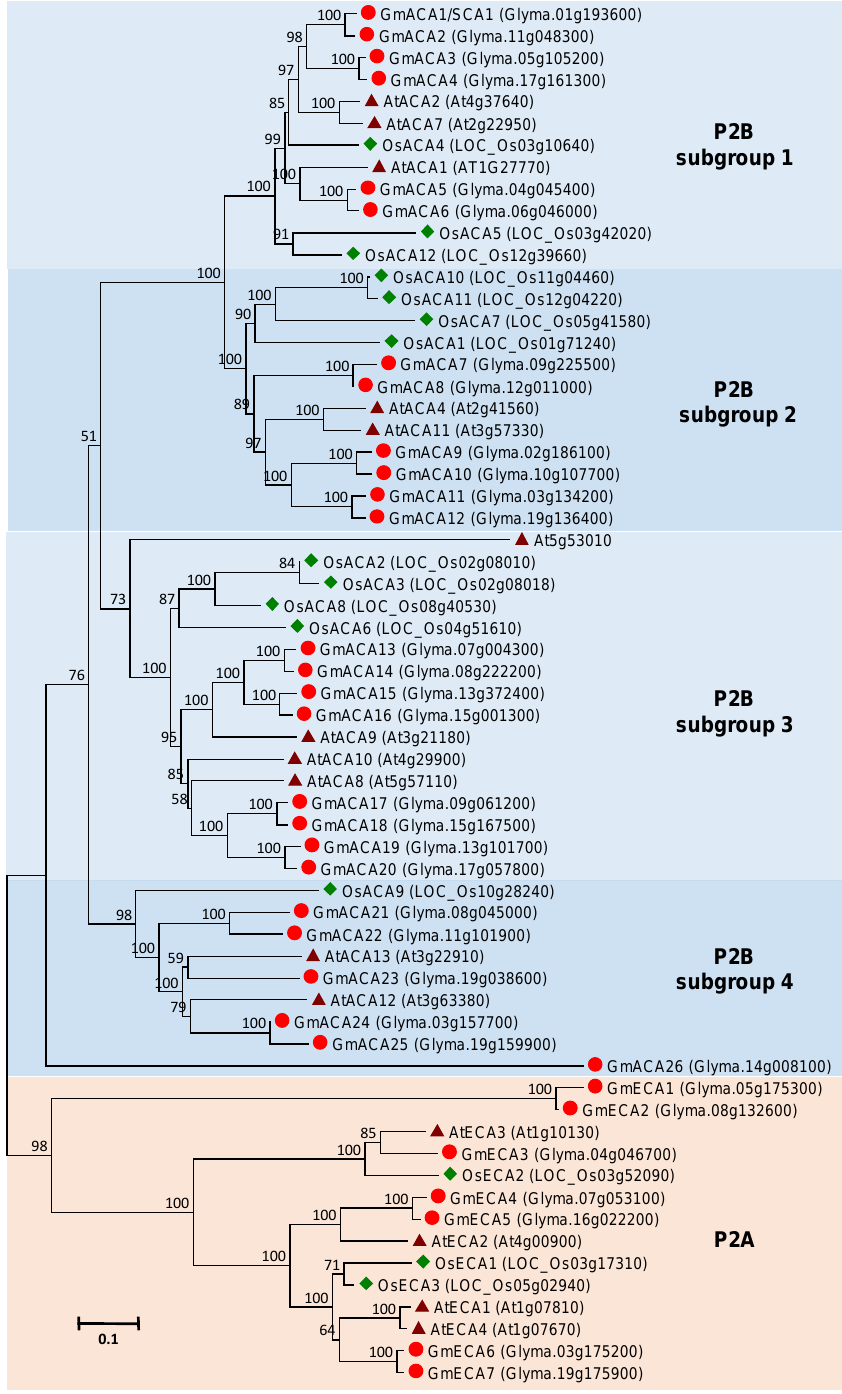
Figure 3. Unrooted phylogenetic tree of the Ca 2+ -ATPase family proteins from soybean ( Glycine max ), rice ( Oryza sativa ), and Arabidopsis thaliana . The alignment for the phylogenetic tree was performed with ClustalW using full-length amino acid sequences. Soybean Ca 2+ -ATPases are marked with red circles, Arabidopsis Ca 2+ -ATPases were marked with purple triangles, while rice Ca 2+ -ATPases were marked with green diamonds. The locus name of each gene is shown in brackets. The bar indicates the relative divergence of the sequences examined, and bootstrap values are displayed next to the branch.